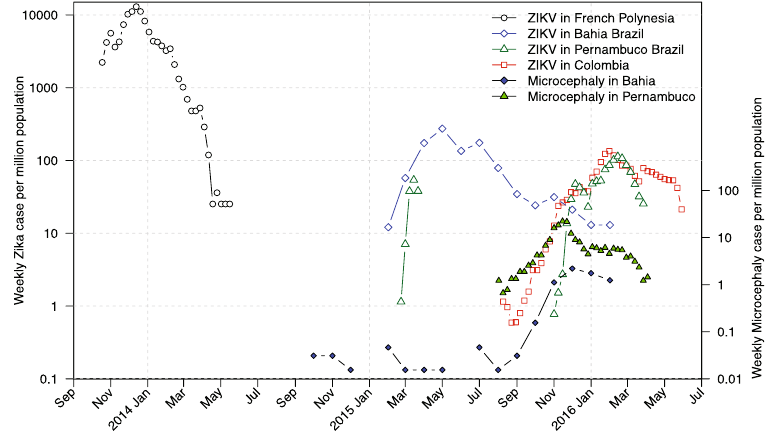
Figure 1. Scaled ZIKV cases and microcephaly cases. ZIKV data from French Polynesia (November 2014 to May 2015), the States of Bahia (February 2015 to February 2016) and Pernambuco (March-April 2015, November 2015 to April 2016) in Brazil, Colombia (August 2015 to June 2016), and microcephaly data from Bahia (July 2015 to February 2016) and Pernambuco (August 2015 - April 2016). All data are weekly except for the State of Bahia in Brazil, which were monthly and had been scaled by 1/4.25 to make them comparable. All time series are scaled by their respective population sizes. Microcephaly data for Colombia are not